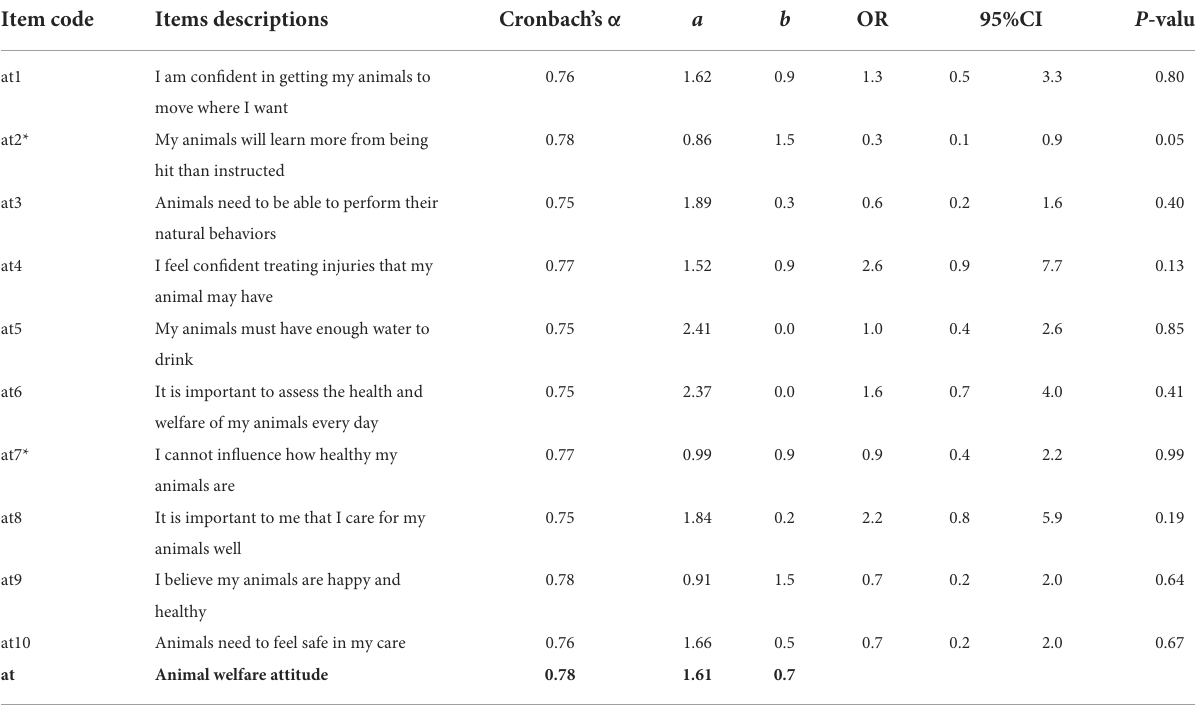
TABLE 5 Cronbach’s alpha, IRT parameter estimates, and uniform DIF for animal welfare attitude